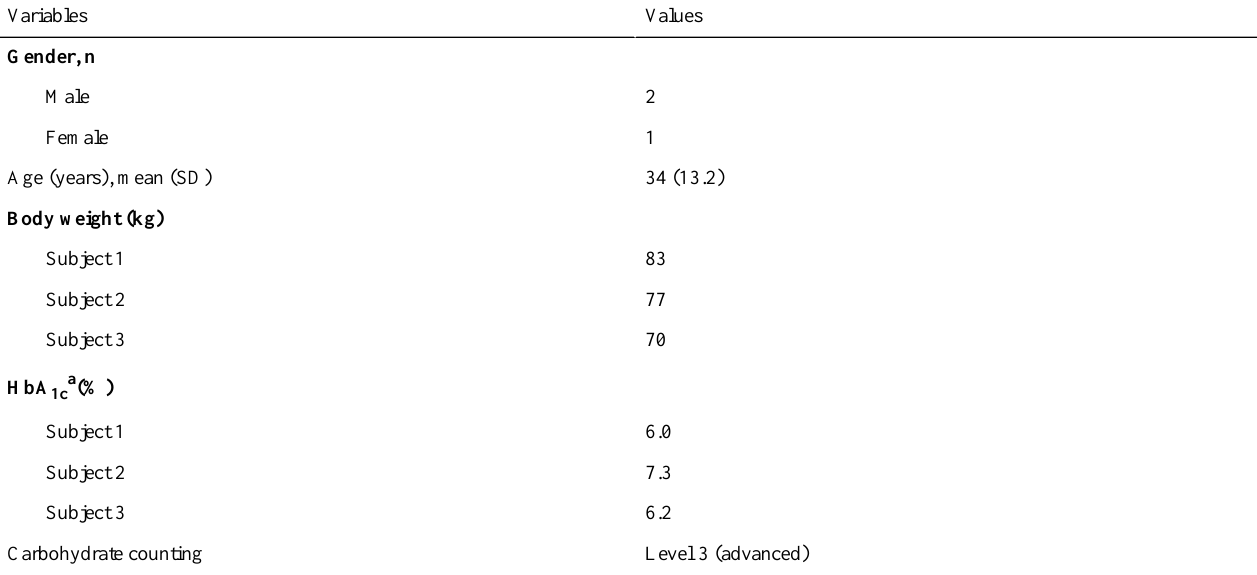
Table 2. Participants